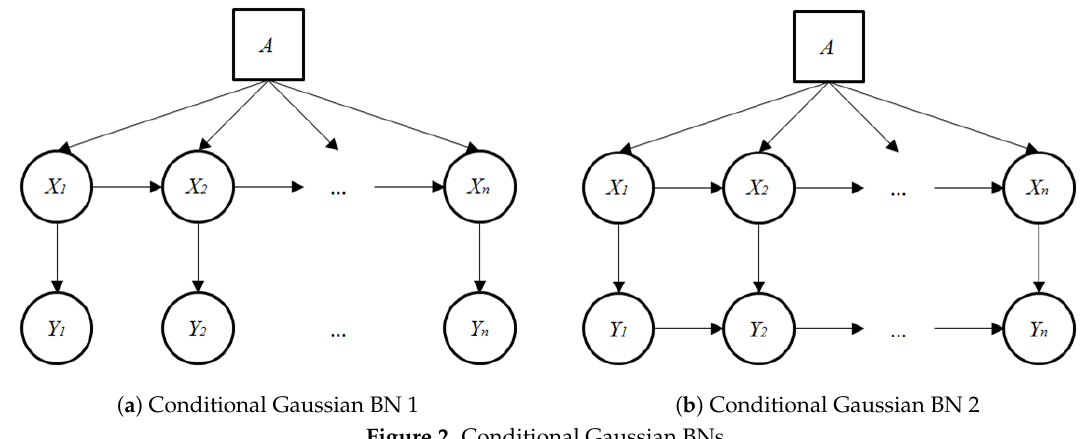
Figure 2. Conditional Gaussian